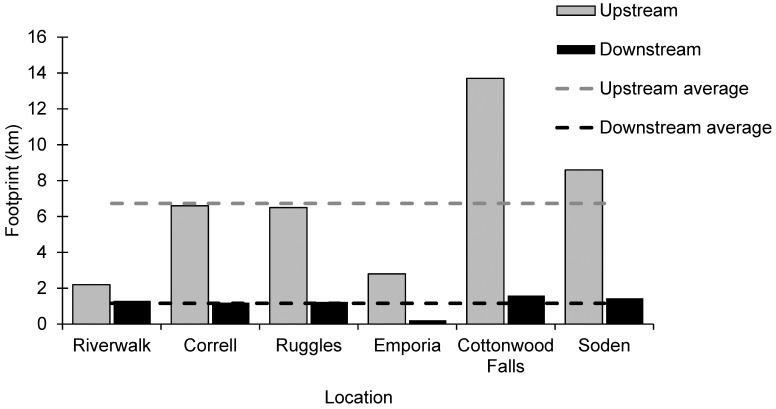
Low-head Dam Footprints.Downstream (black bars) and upstream (gray bars) footprints of six dam sites and the average downstream and upstream footprints in the Neosho River network. The dashed lines are averages.